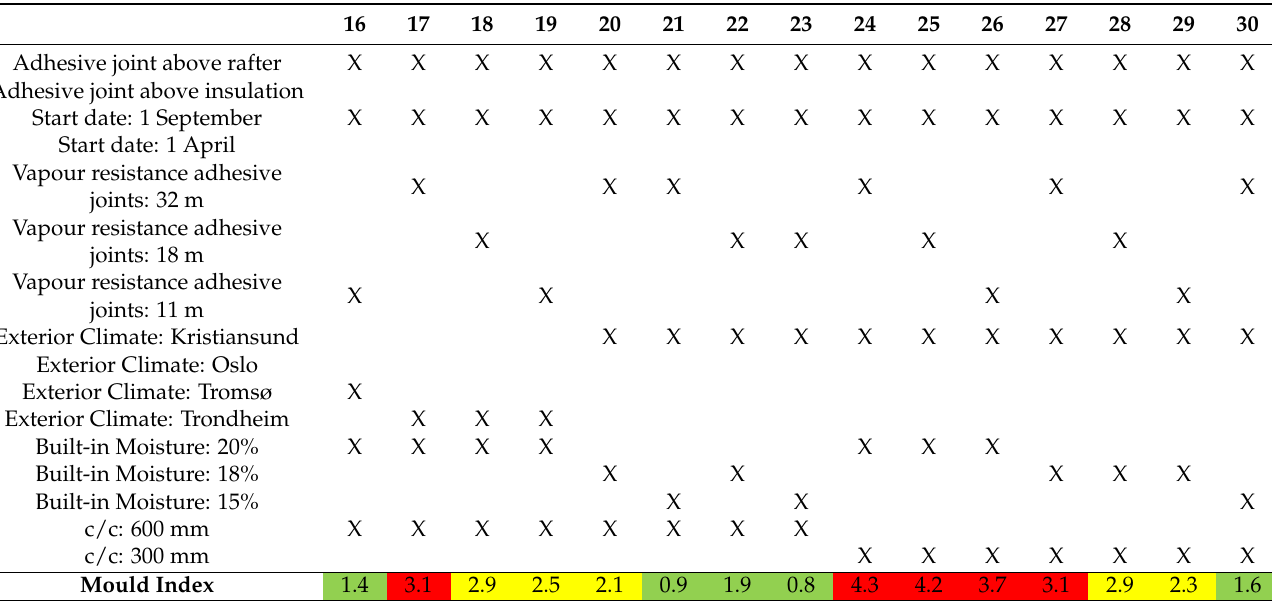
Table 7. Parameter Study and Result from Simulation in WUFI 2D and WUFI Mould Index VTT. Calculations